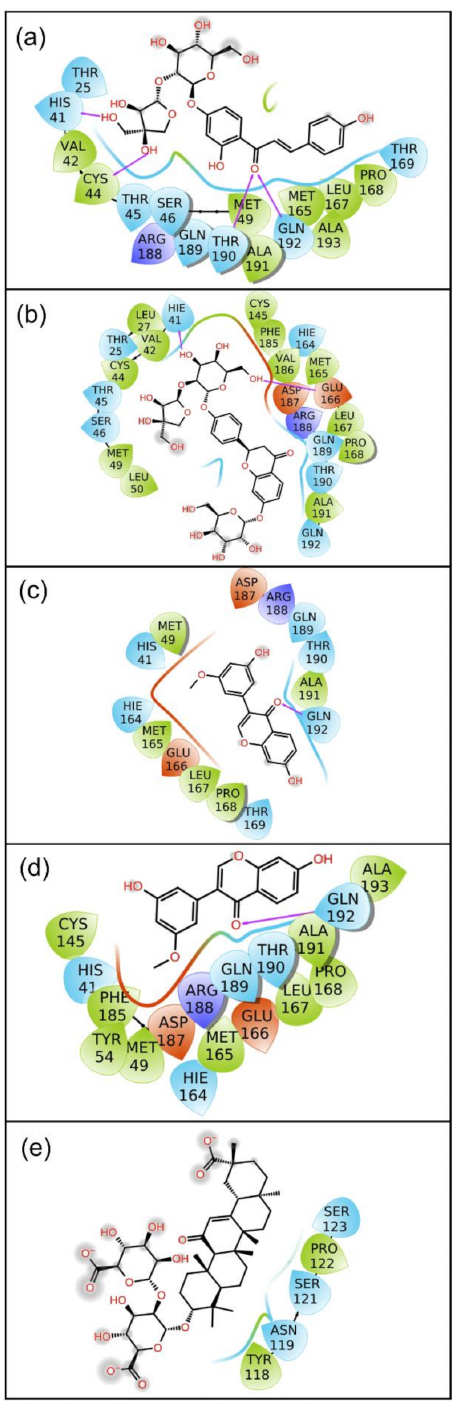
Figure 3. The 2D interaction diagram for the last poses of SARS-CoV-2 M pro docked with bioactive compounds after MD simulations: ( a ) licuraside, ( b ) glucoliquiritin apioside, ( c ) 7,3 (cid:48) -Dihydroxy-5 (cid:48) - methoxyisoflavone, ( d ) licuroside, and ( e ) glycyrrhizin, extracted from 100 ns MD simulation. Herein, hydrogen bond formation (pink arrows), hydrophobic (green), polar (blue), red (negative), violet (positive), glycine (grey), and π - π stacking (green line) interactions are also shown in the respective docked